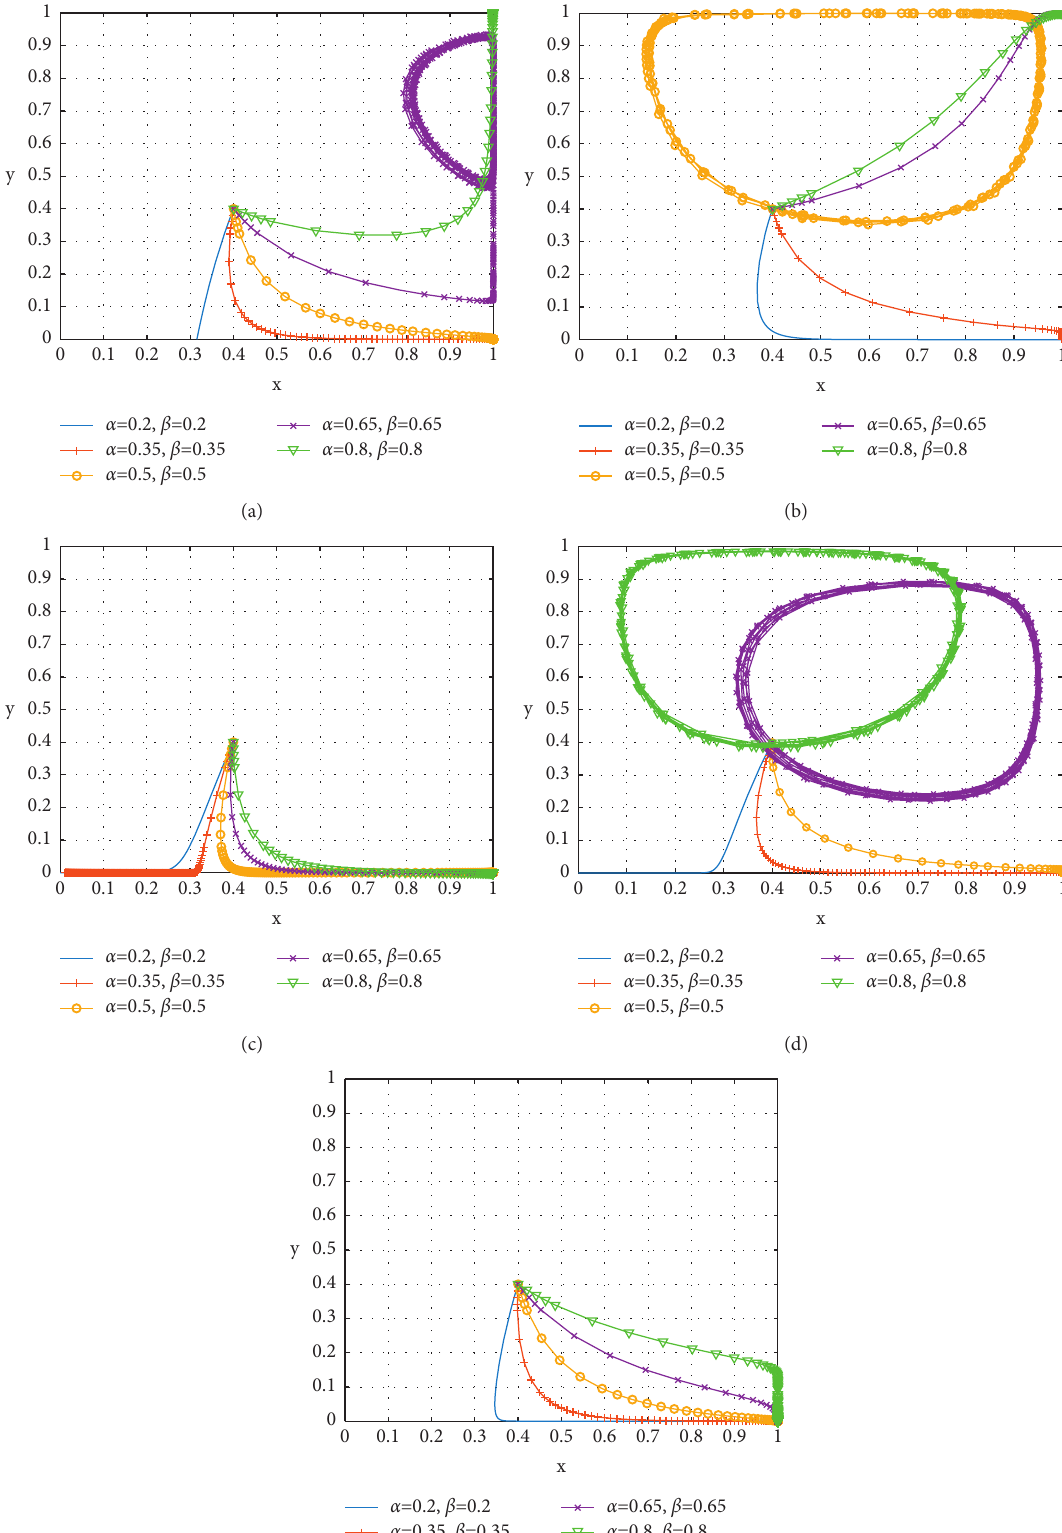
Figure 11: Evolution results with the change of α and β by the initial values in Case 4. (a) A (c) A p � 1 , A s � 1. (d) A p � 1 , A s � − 1. (e) A p � − 1 , A s �